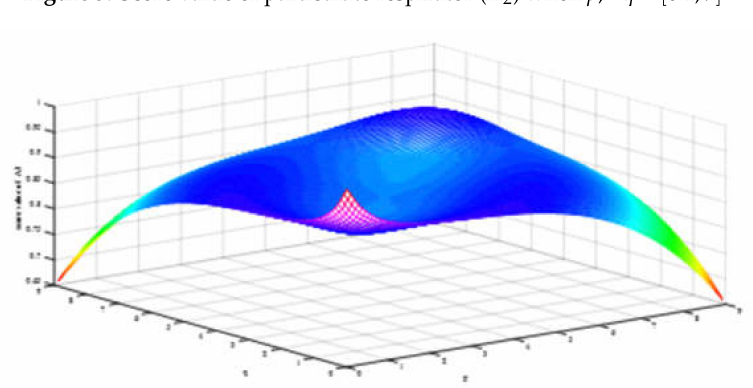
Figure 3. Score value of particulate respirator ( A 2 ) when p , q ∈ [ 0.1,9 ] .